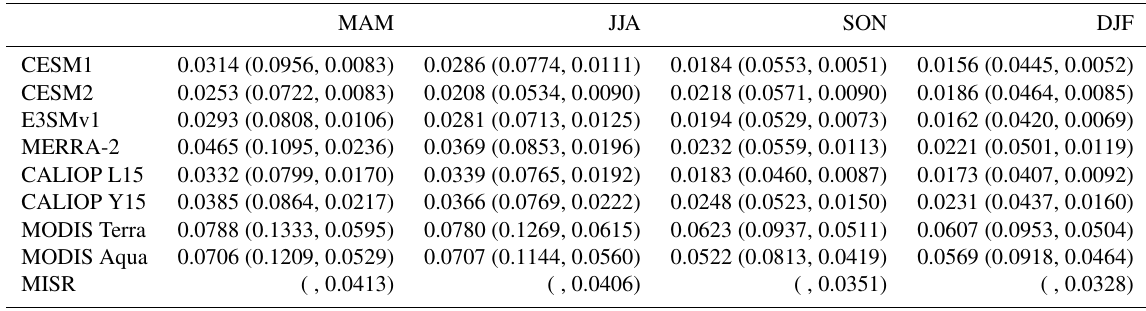
Table 3. Global seasonal mean DOD (60 ◦ S–60 ◦ N).